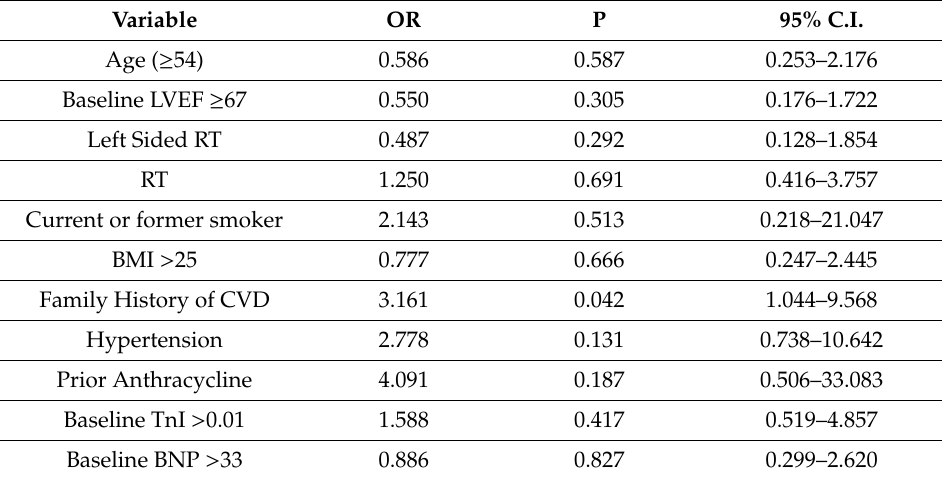
Table 2. Univariate analysis of predictors of